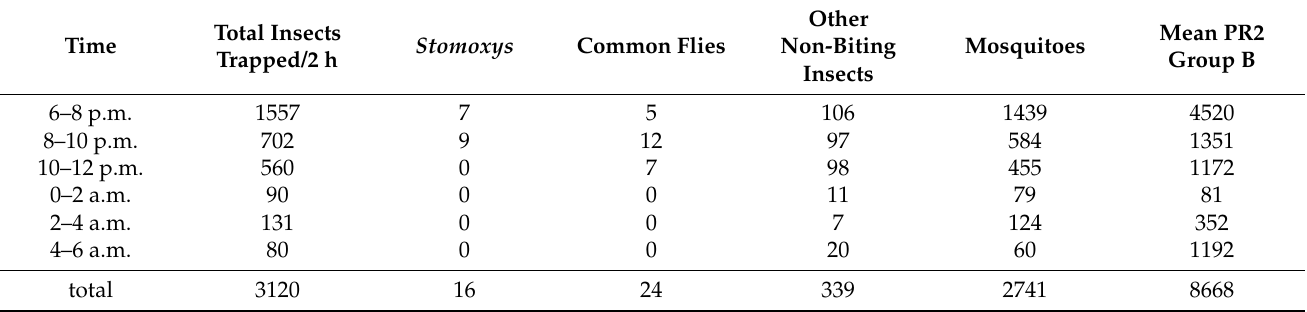
Figure 8. ( a ) Mean monthly nocturnal (PR12n) and diurnal tail pedometer records (PR12d) of Group A. Comment: PR12n are constantly below 200/night, while PR12d are constantly around 800/day; there are very light variations along the seasons. ( b ) Mean monthly nocturnal (PR12n) and diurnal tail pedometer records (PR12d) of Group B and mean monthly daily hematophagous fly apparent density per trap (ADT). Comment: PR12n (dark grey) are very high (around 6000 bits/night) during rainy season, in August–October and they further decrease down to 1000–2000 bits/night (December– March)t; PR12d (light grey) obviously follow the variations of fly density (black broken line), with high scores from August to November (10,000–14,000 bits/day) and they further decrease when fly density is low in January–March, with scores of 4000–6000 bits/day. Table 3. Insects trapped with CDC trap at night per 2 h sessions on 21–22 November 2016 and mean PR2 of cattle in Group